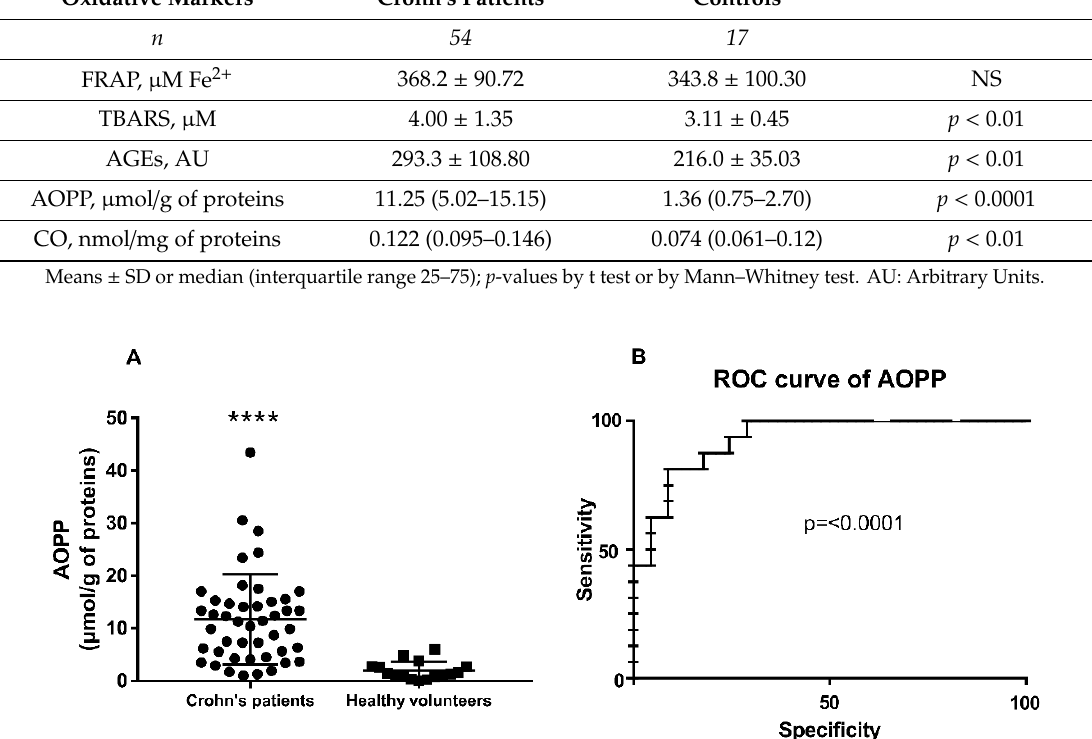
Table 2. Mean values of oxidative markers in serum samples from Crohn’s patients or healthy volunteers.